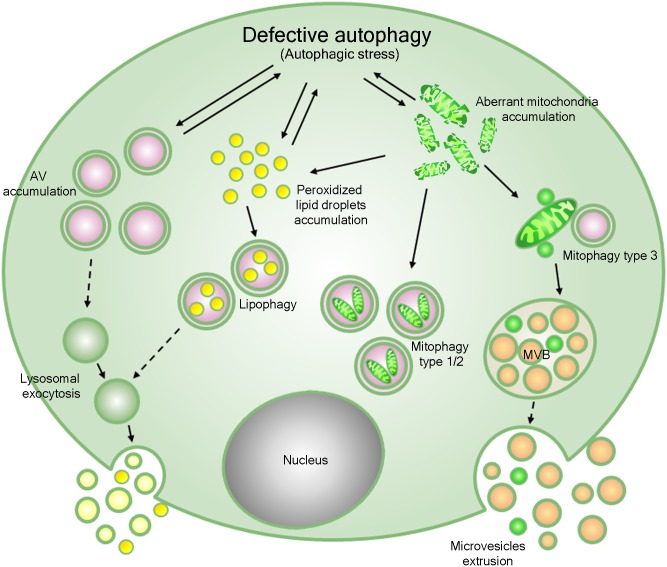
A proposed model for the pathogenesis of Niemann-Pick disease type B.Defective ASMase and lysosomal storage could lead to a reduced ability of lysosomes to fuse with autophagosomes. This in turn could result in a partial block of autophagy maturation and defective degradation, accompanied by accumulation of autophagic vacuoles, peroxidized lipid droplets and aberrant mitochondria (autophagic stress). Additional evidence and hypotheses are more fully explained in the text. Dotted lines: proposed mechanism; solid lines: proven mechanism.